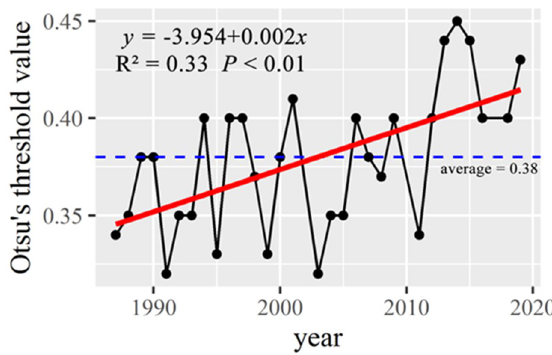
Figure 4. Annual Otsu NDVI threshold change on Gongga Mountain from 1987–2019.